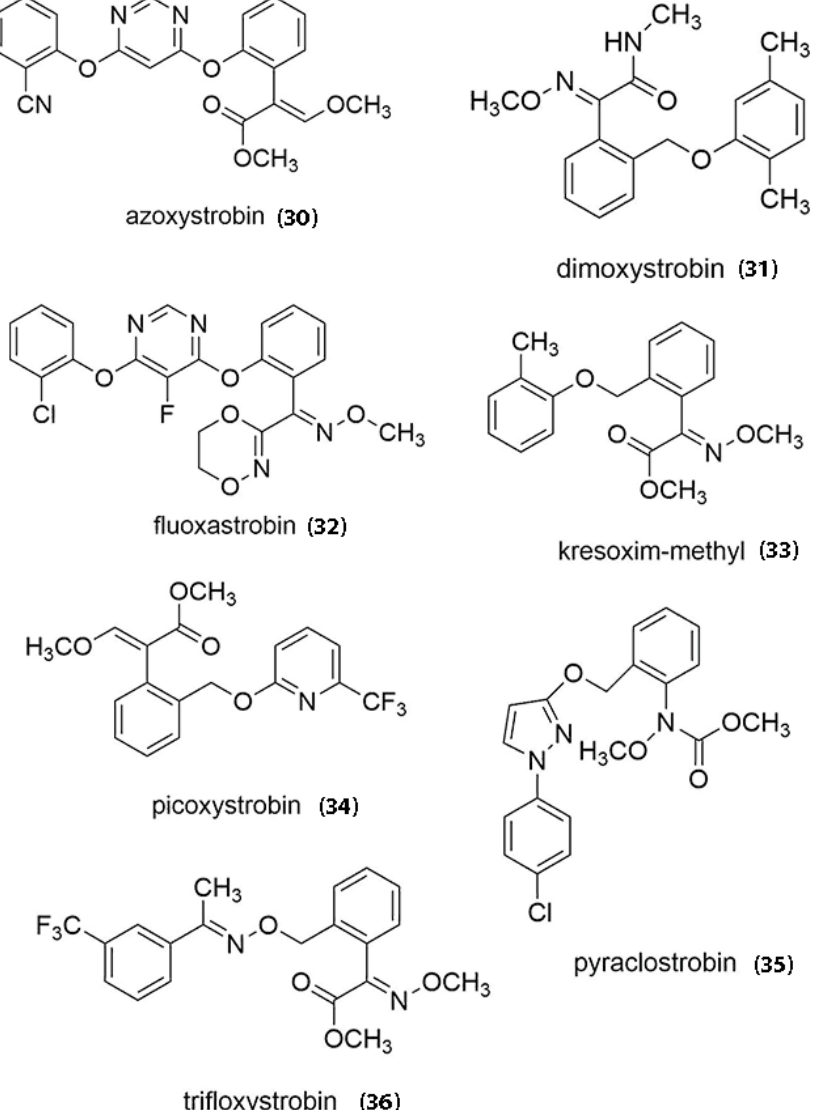
Figure 10. Chemical structures of synthetic strobilurins on the market.